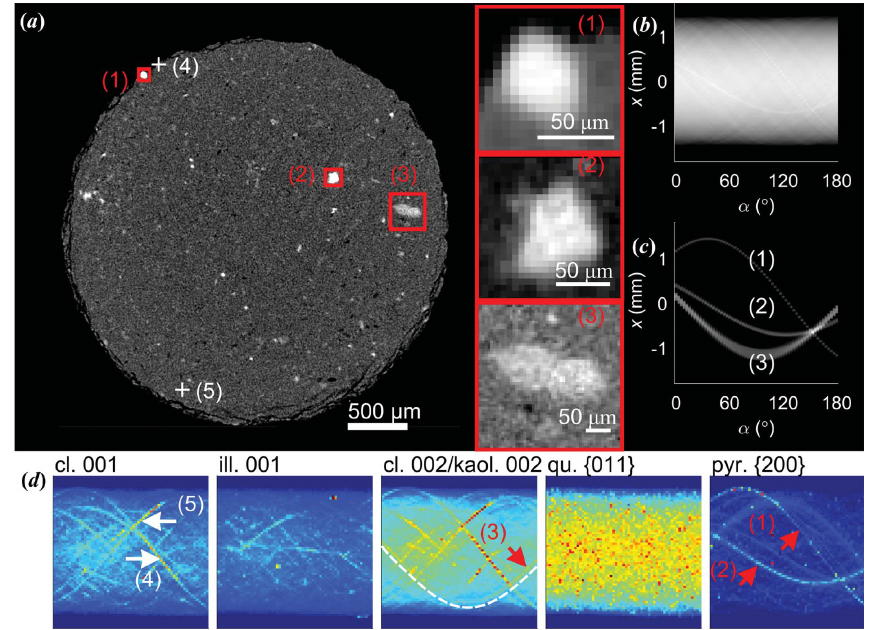
Figure 6 Identification of clastic mineral composition by comparing attenuation- and XRD-contrast sinograms. ( a ) An attenuation-contrast cross section of the sample. Three inclusions are marked with red rectangles and have been magnified. A sinogram (Radon transform) of the entire cross section in ( a ). ( c ) A sinogram made by including only the bright regions indicated by the red rectangles in ( a ). ( d ) XRD-CT sinograms based on clinochlore 001, illite 001, clinochlore 002/ kaolinite 002, quartz {011} (overlapping with clinochlore and illite), and pyrite {200}. All sinograms are displayed with different intensity scales. The white dashed line is a guide to the